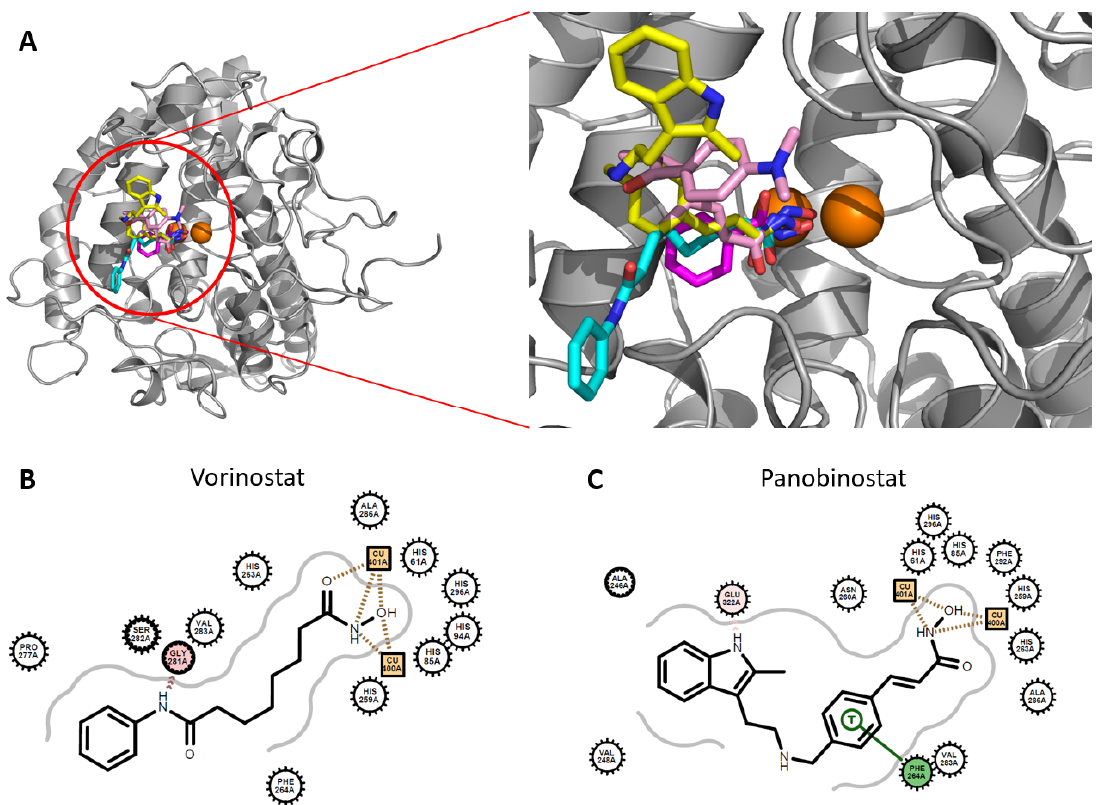
Figure 6. Predicted poses of hydroxamate-containing HDAC inhibitors. ( A ) Overlaid poses of hydroxamate-containing molecules docked to mushroom tyrosinase. Molecules in cyan, yellow, pink, and magenta indicate vorinostat, panobinostat, trichostatin A, and benzohydroxamic acid, respectively. Brown spheres represent copper atoms. Dockings were performed using Glide-SP with mushroom tyrosinase (PDB ID: 2Y9X) as a template. ( B , C ) 2D diagrams of docked poses for vorinostat and panobinostat. The OpenEye Grapheme package was used to analyze and visualize intermolecular interactions. For the definition, see Figure S3.